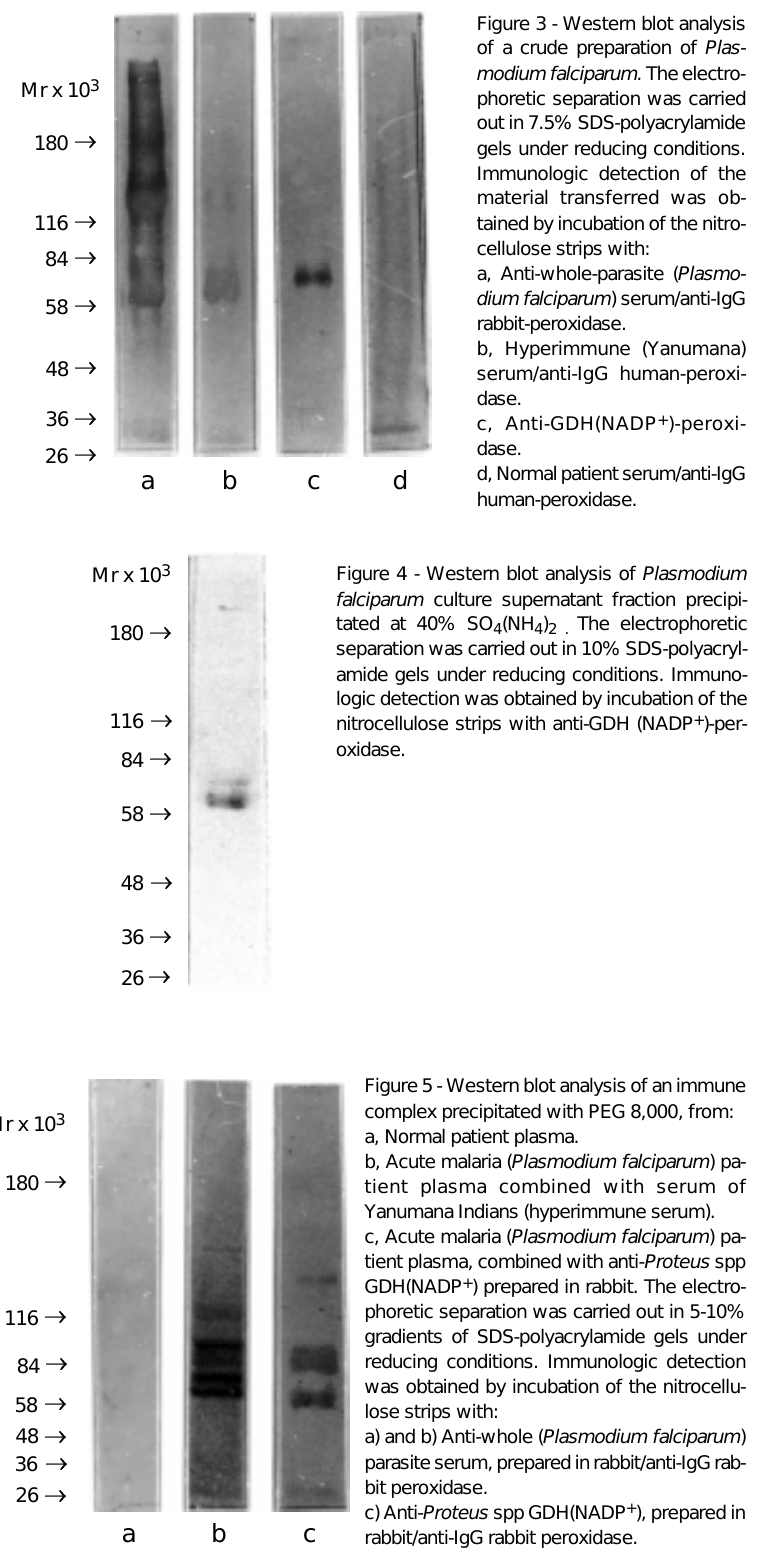
Figure 3 - Western blot analysis of a crude preparation of Plas- modium falciparum. The electro- phoretic separation was carried